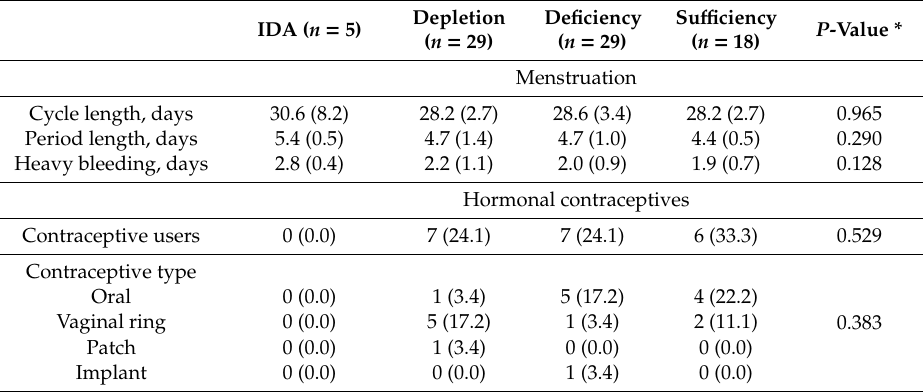
Table 4. The gynaecological characteristics of women according to iron status.